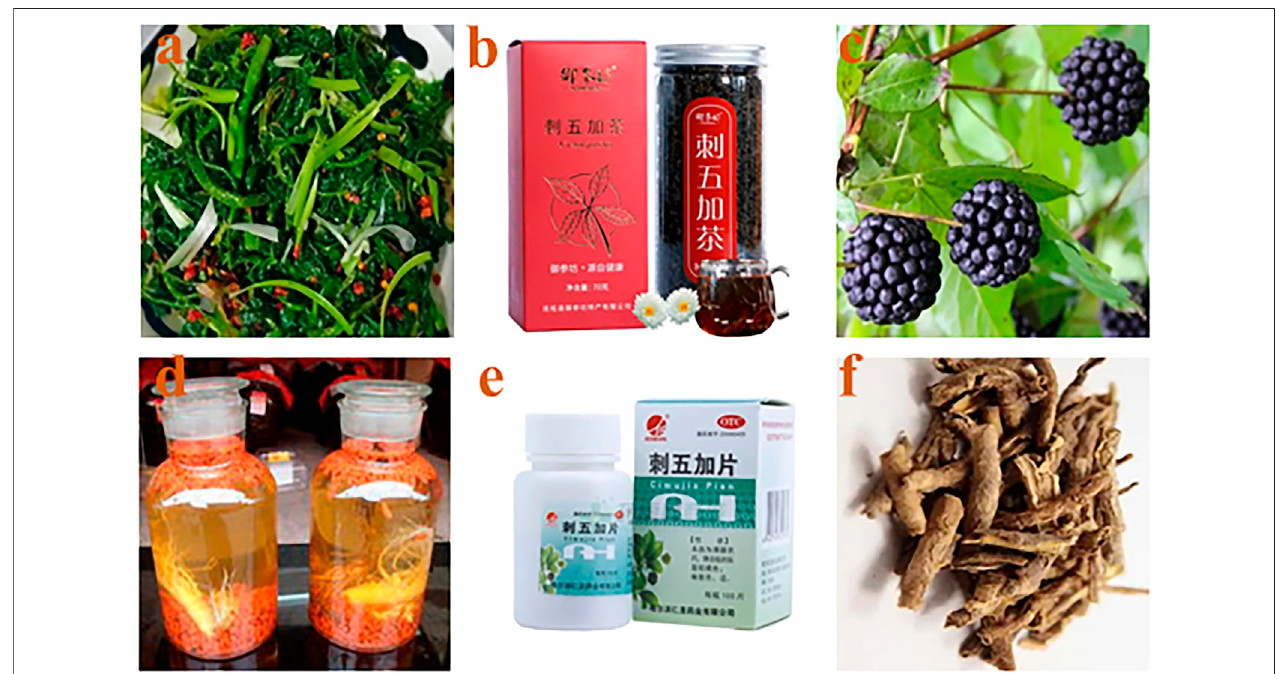
FIGURE 1 | Eleutherococcus senticosus. Salad from leaves (A) ; tea (B) ; pulp (C) ; wine (D) ; tablets (E) ; cortex (F)